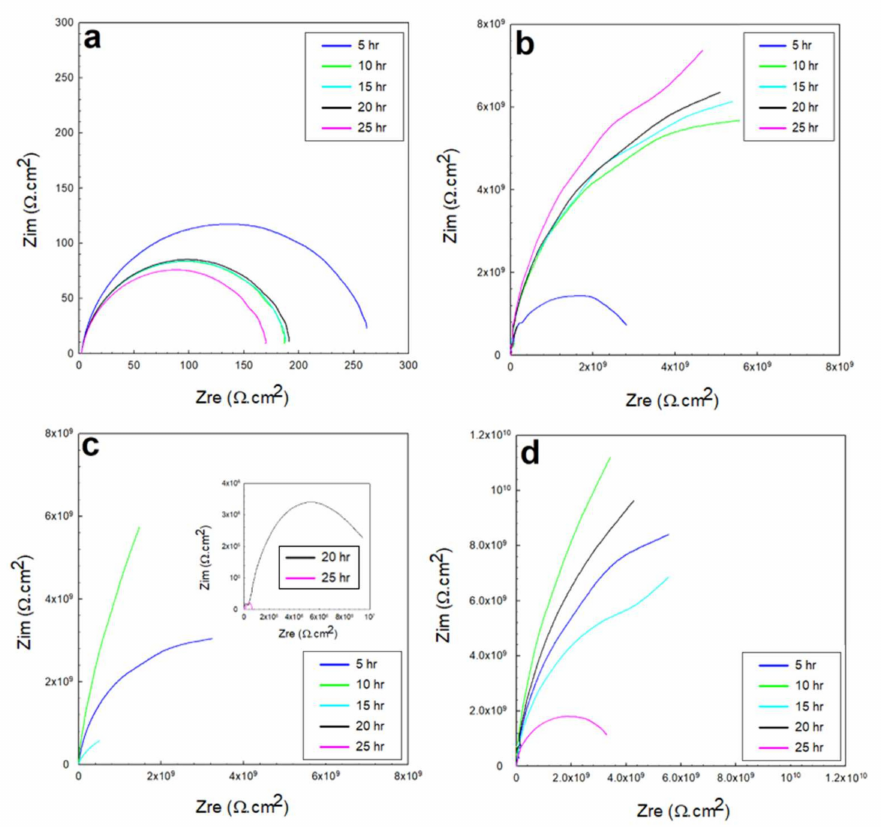
Figure 11. EIS Nyquist plots of the 0.5 M H 2 SO 4 solution for: ( a ) exposed steel, ( b ) glass/epoxy, ( c ) Kevlar/epoxy, and ( d ) epoxy systems.